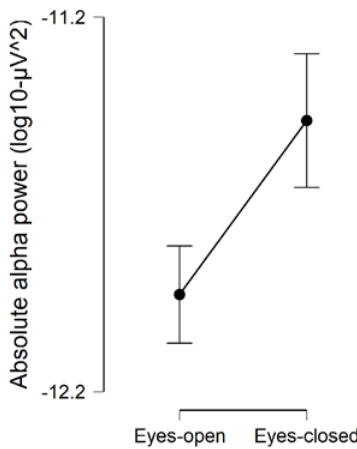
Figure 1. Comparison of absolute alpha power during eyes-open and eyes-closed resting-state conditions. Error bars are 95% credible intervals.